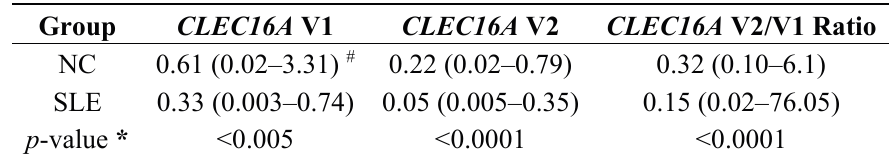
Table 2. CLEC16A isoform expression # in PBMCs of healthy controls and SLE patients.